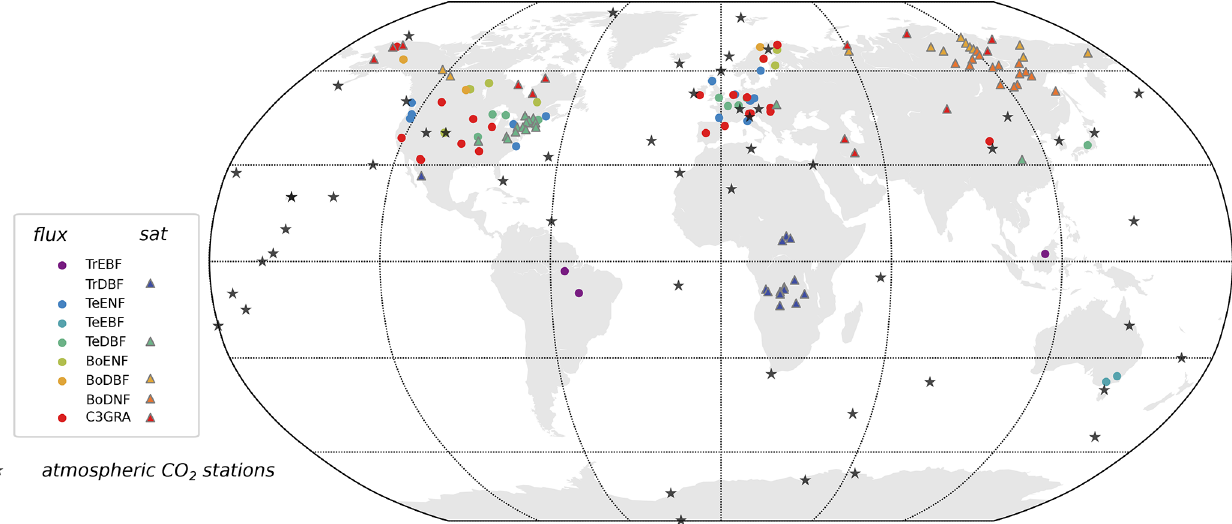
Figure 1. Location of the flux tower sites (circles), satellite pixels (triangles) and atmospheric CO 2 stations (black stars) used in this